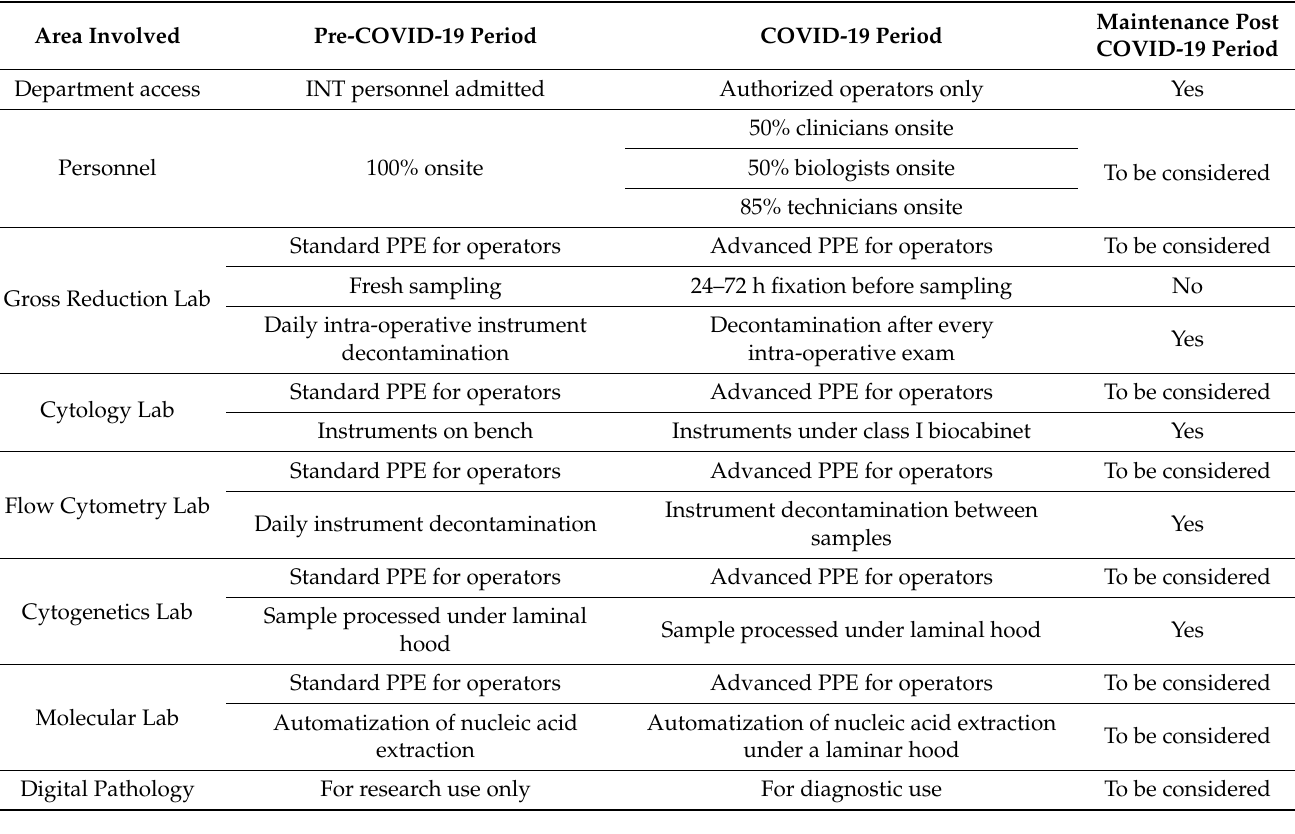
Table 1. Summary of the pre- and post-COVID-19 operating procedures modified within the Department of Pathology. Area